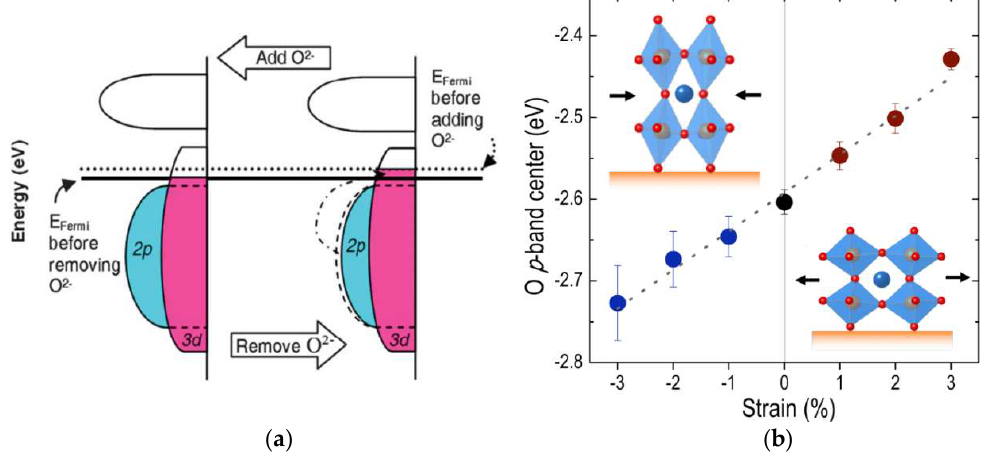
Figure 4. ( a ) Schematic electronic structure plots to illustrate the correlation of the ORR energetics vs. the O p-band center based on the rigid band model. Reprinted from [100] with permission of The Royal Society of Chemistry. ( b ) DFT calculations for the oxygen 2p-band center with respect to the Fermi level as a function of strain in LSCO films. The calculated oxygen 2p-band centers are averaged over LSCO films with five different Sr orderings. Reprinted from [96] with permission of The American Chemical Society.